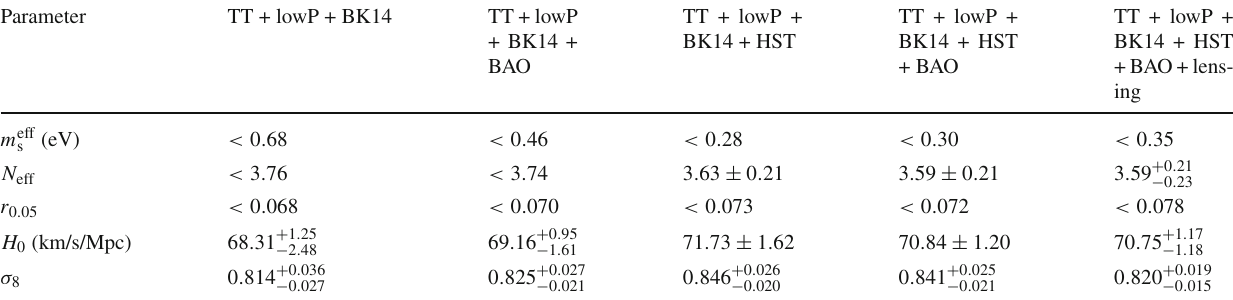
Table 3 Bounds on cosmological parameters in the (cid:2) CDM + r 0 . 05 + N eff + m eff s model with BK14 data. Marginalized limits are given at 68% C.L. whereas upper limits are given at 95% C.L.. Note that H 0 and σ 8 are derived